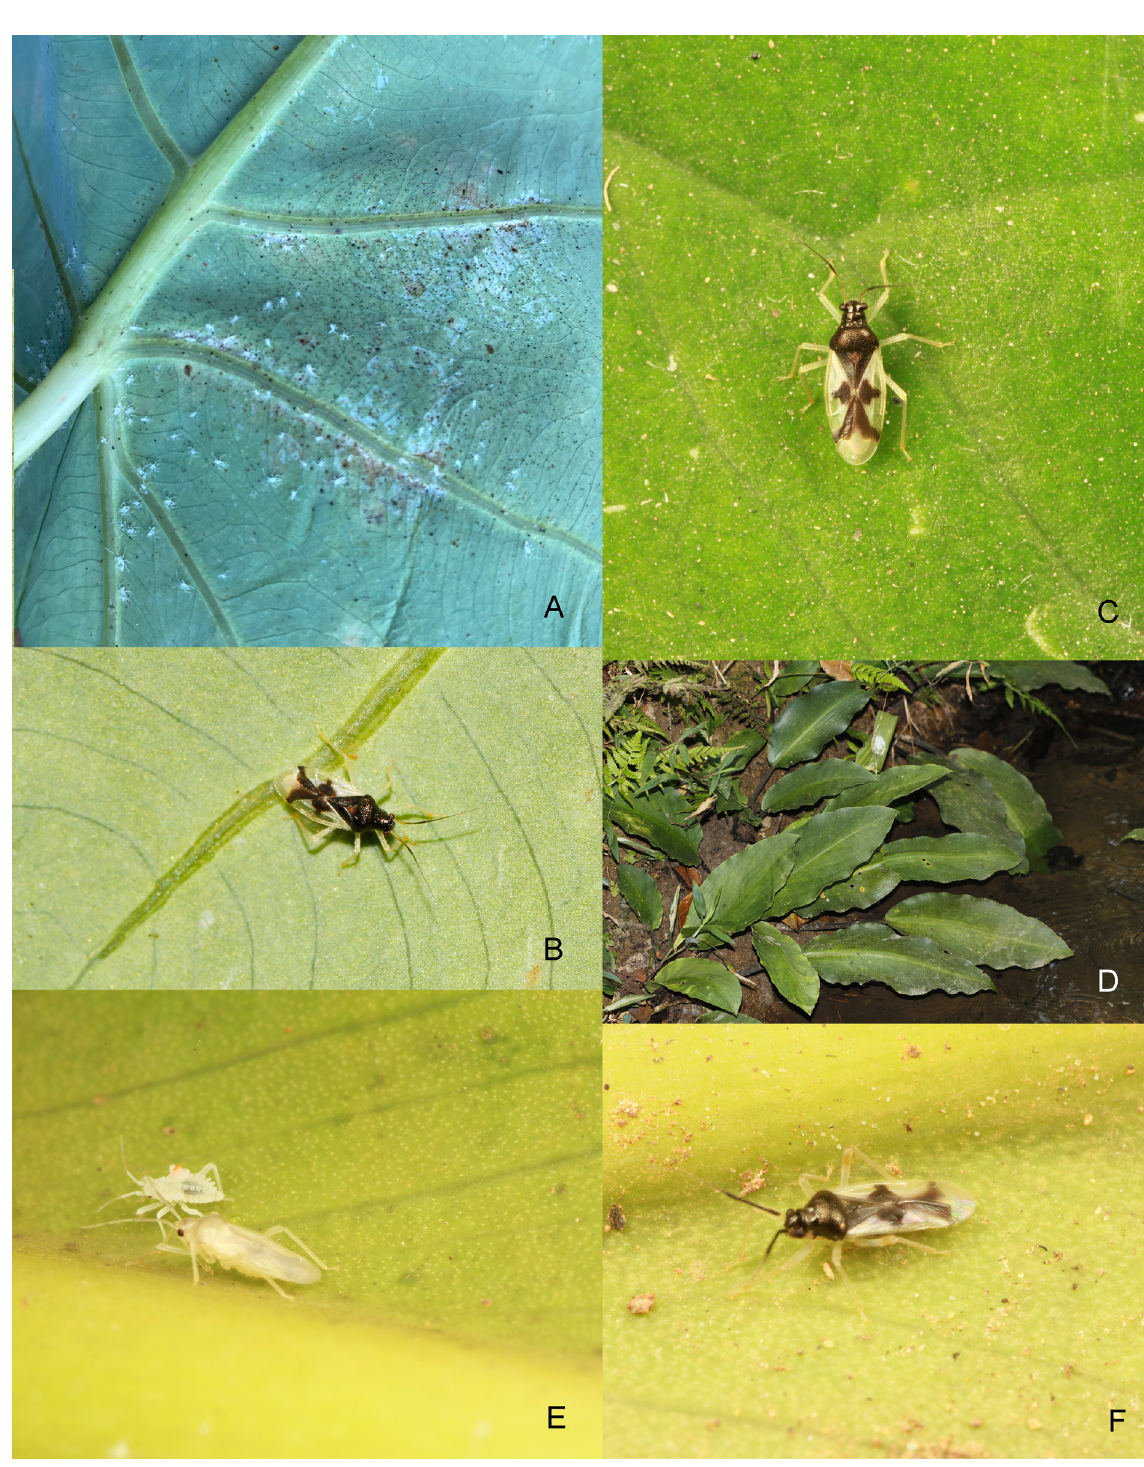
Fig. 26. Habitats and living specimens. A–C . Ernestinus ramkeshariae Yasunaga & Ishikawa, 2016 on Colocasia esculenta. A . Nymphs. B–C . Adult. D–F . Ernestinus mimicus Distant, 1911 on Lagenandra sp. D . Aquatic habitat. E . Nymph and freshly moulted adult. F . Adult. All specimens at